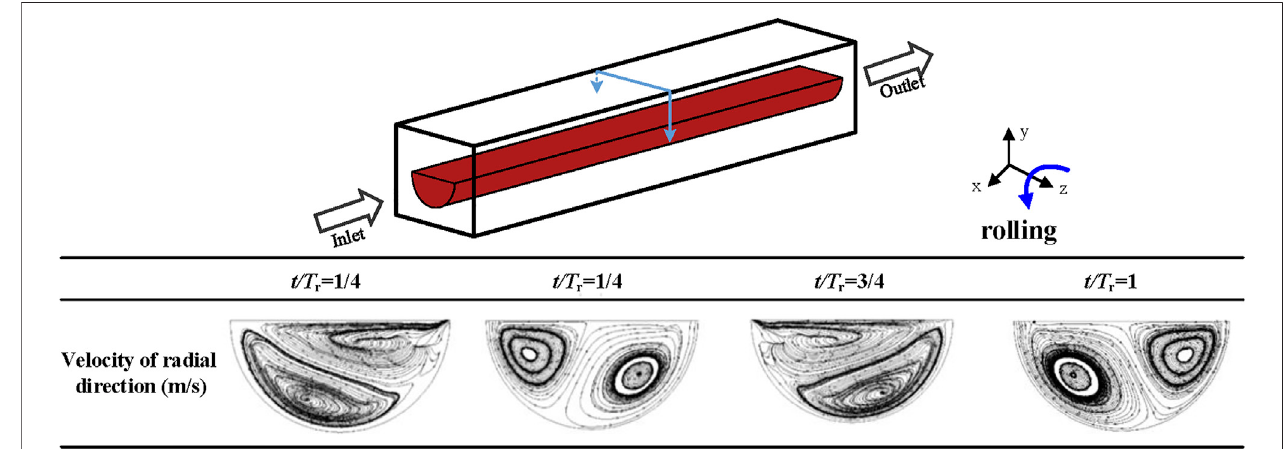
FIGURE 9 | Effect of sloshing on the fl ow fi eld in the radial direction (Ma et al., 2021).